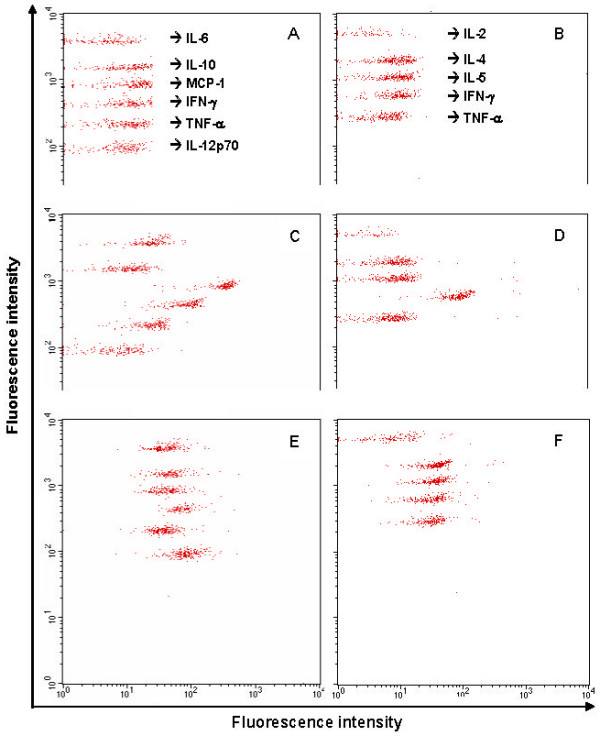
Serum cytokine levels as evaluated by cytometric bead array (CBA). Representative plots show serum cytokine levels of control mice injected every other day for 3 weeks with isotonic saline solution (A) and following 3-week (B) or 5-week (C) exposure to cadmium acetate. Animals were sacrificed and blood samples were collected by heart puncture. Following separation of sera, cytokine content was evaluated by CBA as described in Materials and Methods.